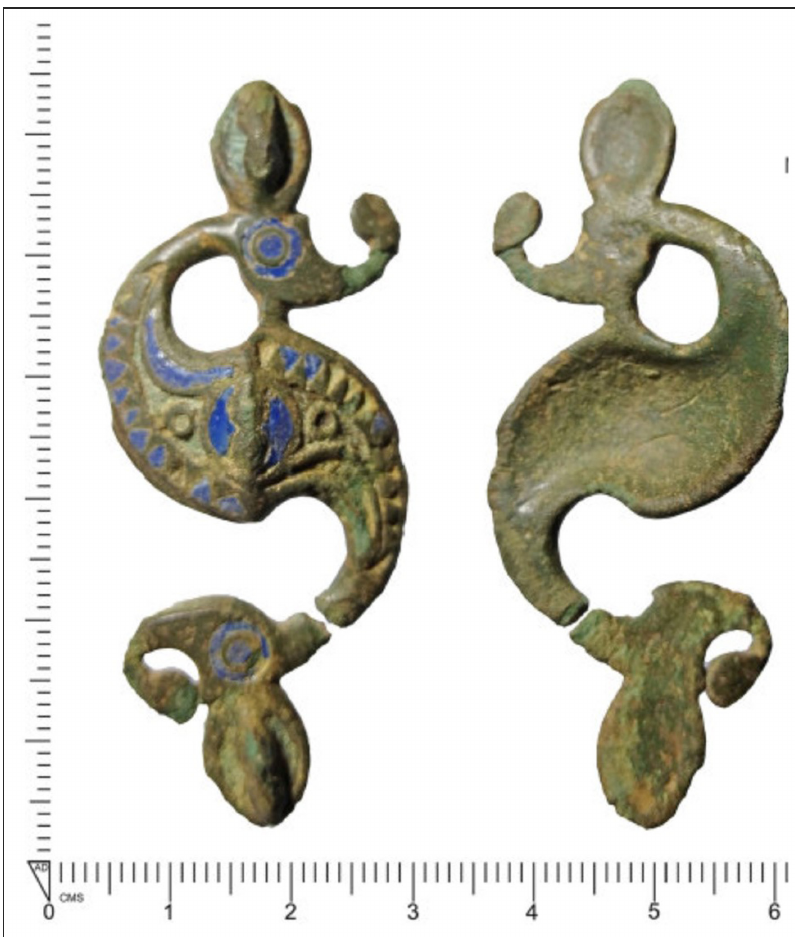
Figure 4: Dragonesque brooch found in Yorkshire (Image curtsey of the Portable Antiquities Scheme, Record ID: